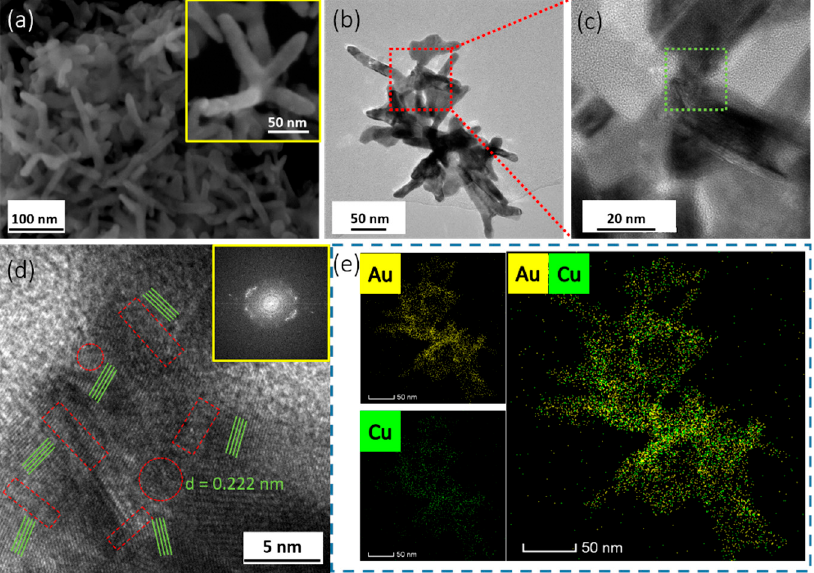
Figure 1. Schematic illustration of the preparation procedure of AuCu.